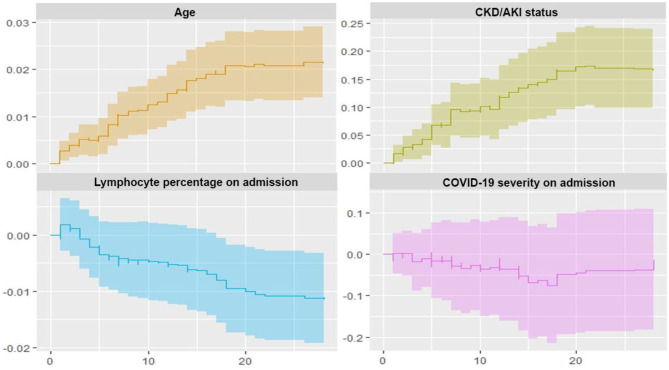
Estimation of cumulative excess risk of based on Aalen's additive model. Aalen's additive model supplements a proportional hazards regression model analysis that describes the nature of time-varying effects of covariates through plots of the estimated cumulative regression coefficients, with confidence bands. AKI, acute kidney injury; CKD, chronic kidney disease.